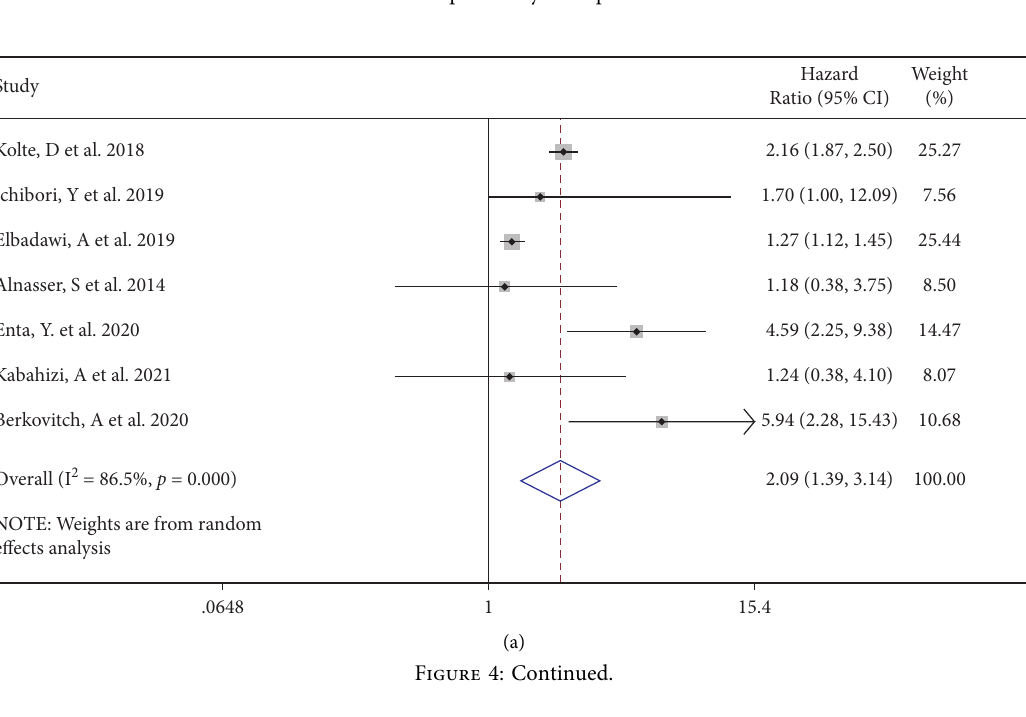
Figure 3: Funnel plot analysis of publication bias.